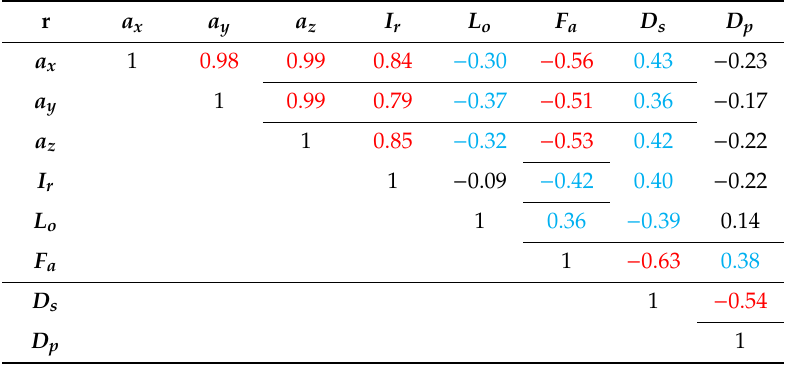
Table 2. Correlation coe ffi cients for dynamic responses and weather